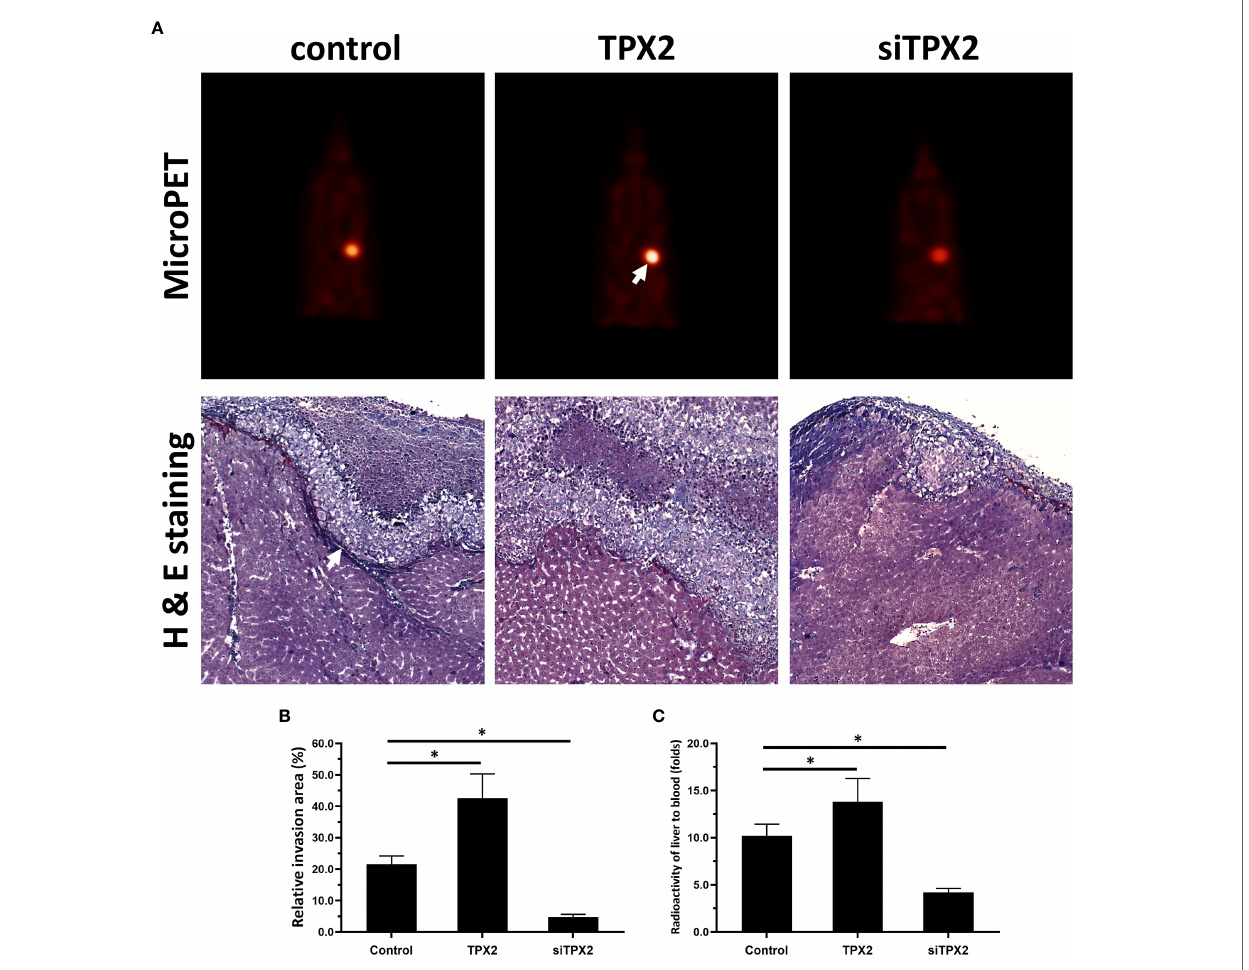
FIGURE 6 | TPX2 enhanced the in vivo invasion of PC-3 cells. PC-3 cells were transfected with the control, TPX2 or siTPX2. The cells were mixed with hydrogel and adhered onto the surface of the liver organs of nude mice. The lesions formed by the PC-3 cells were measured using micro-PET and pathological analysis. The results were shown as micro-PET images or pathological analysis (A) and the quantitative results of the images (B, C) .